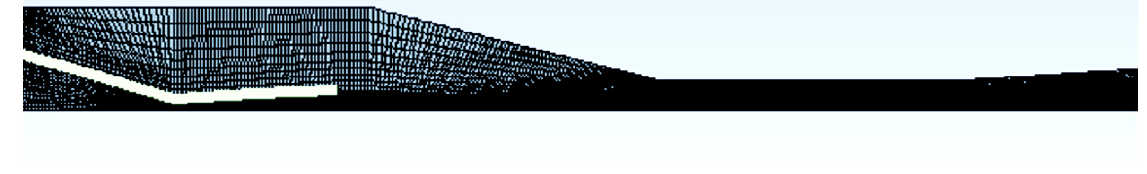
Figure 5. Structured meshing for AG1 with 9940 elements for axisymmetric modeling.